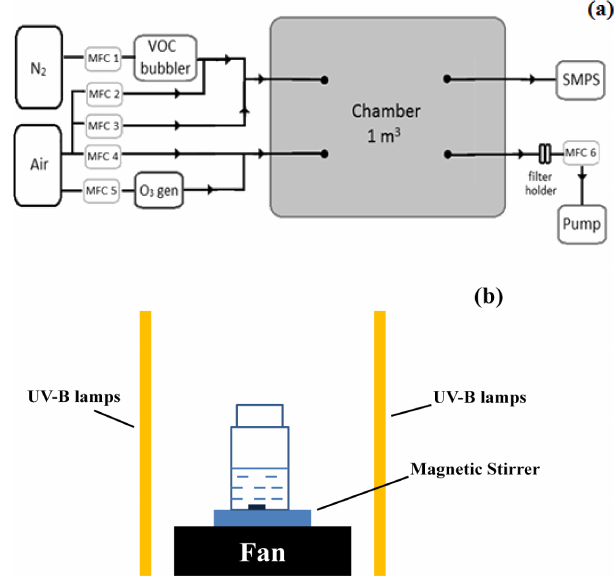
Figure 1. Schematic diagrams of the environmental chamber (a) and the photoreactor (b)